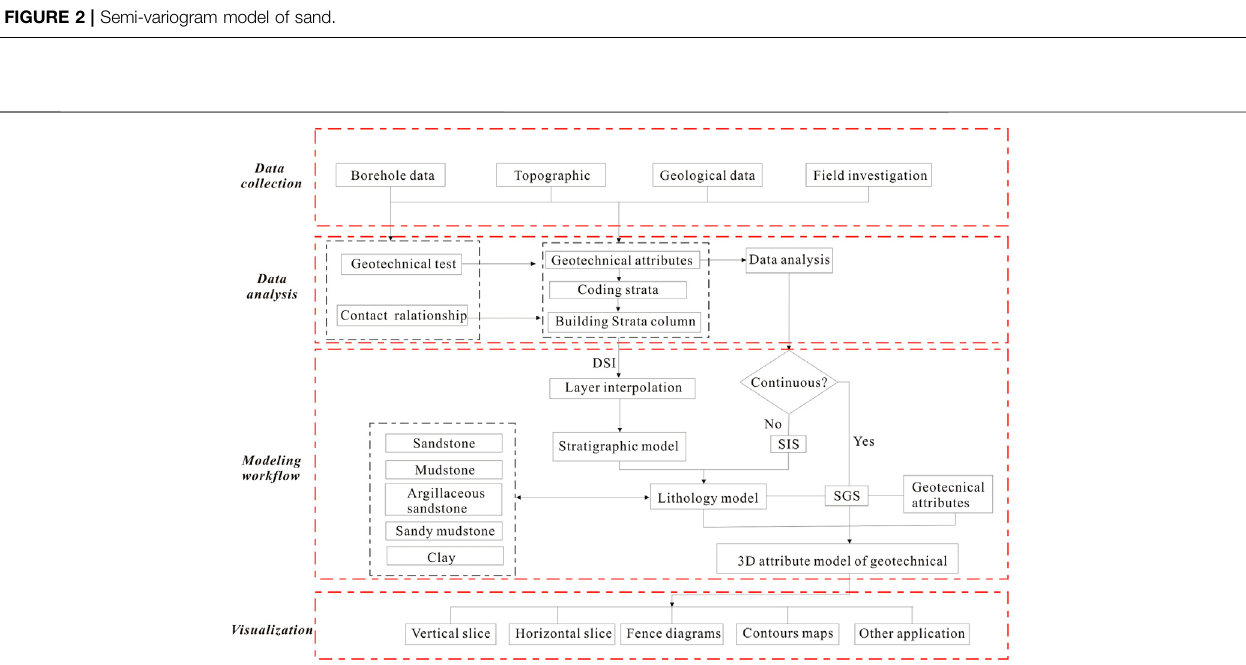
FIGURE 3 | Work fl ow of 3D geological